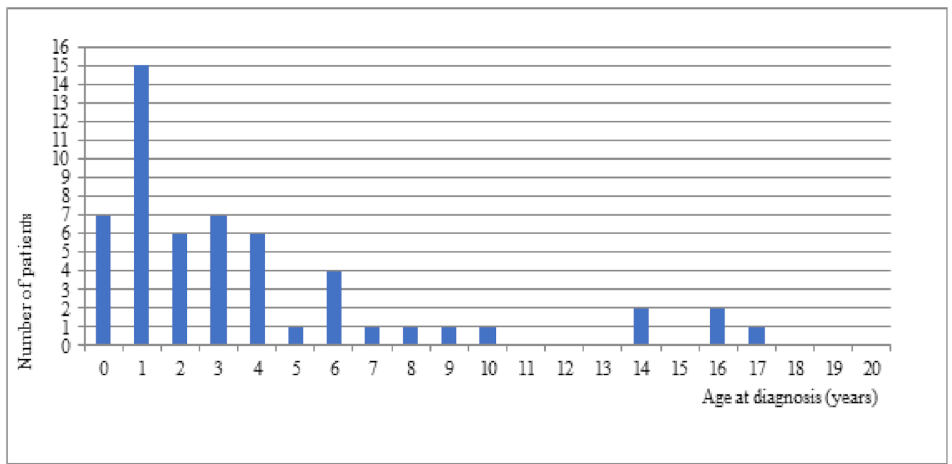
Figure 2. Age at